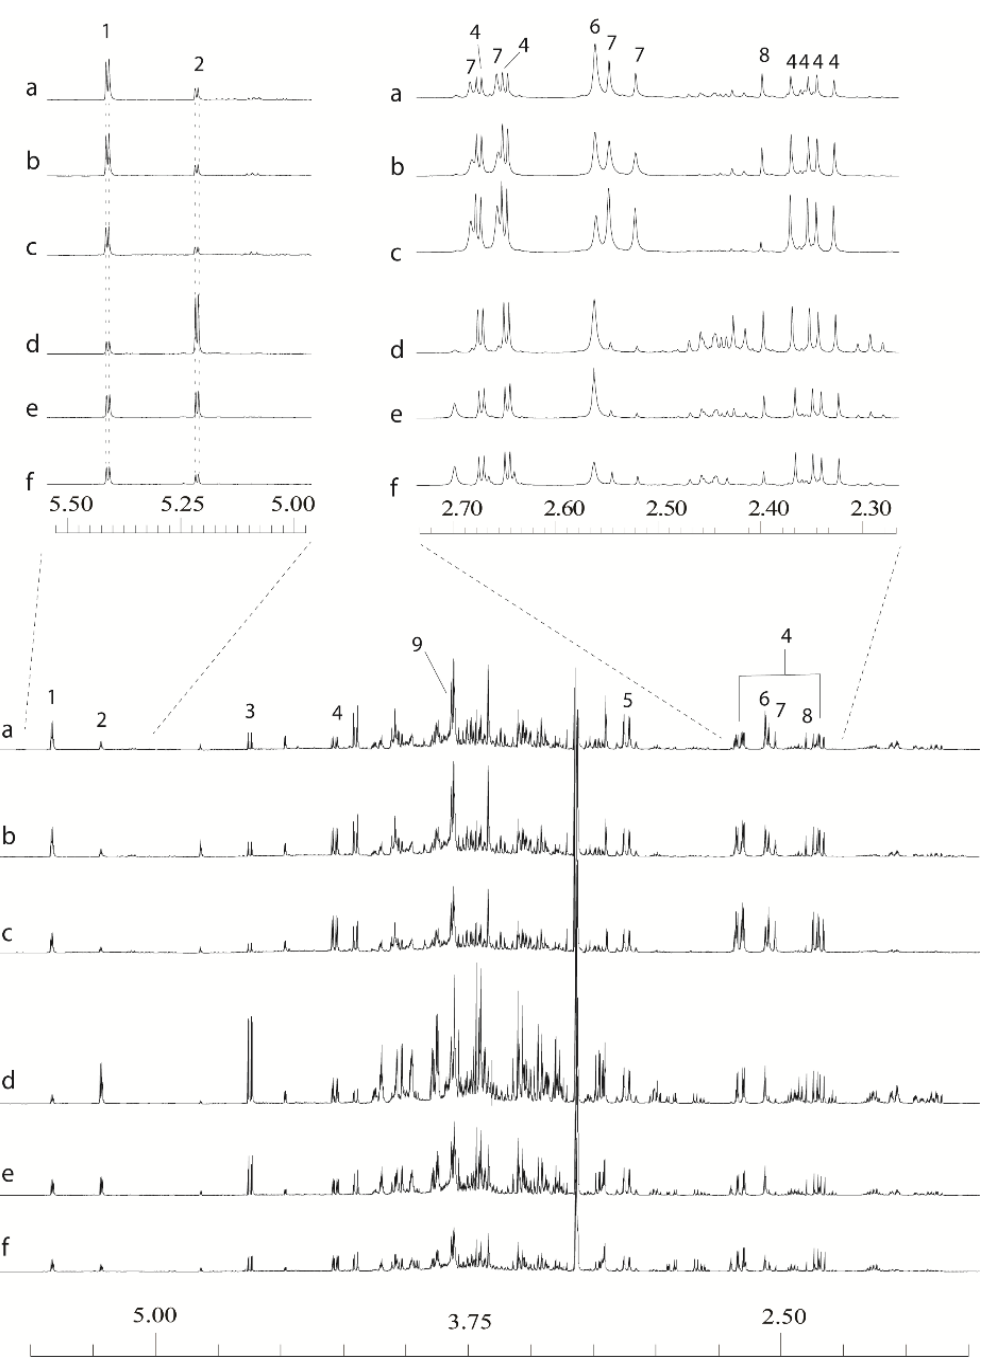
Figure 2. Examples of leaf and stem 1D 1 H-NMR data derived from extracts made using an:80:20 D 2 O:CD 3 OD extraction with final additions of 20 µL 2.6 M potassium phosphate buffer and 10 µL 32 mM ethylenediaminetetraacetic acid ( EDTA) solutions in D 2 O. ( a ) Resolution-leaf-top; ( b ) Tora-leaf-middle; ( c ) Resolution-leaf-bottom; ( d ) Tora-stem-top; ( e ) Resolution-stem-middle; ( f ) Resolution-stem-bottom. 1: sucrose; 2: α-glucose; 3: β-glucose; 4: malate; 5: Ca-EDTA 2− ; 6: Ca-EDTA 2− ; 7: citrate; 8: succinate; 9: free